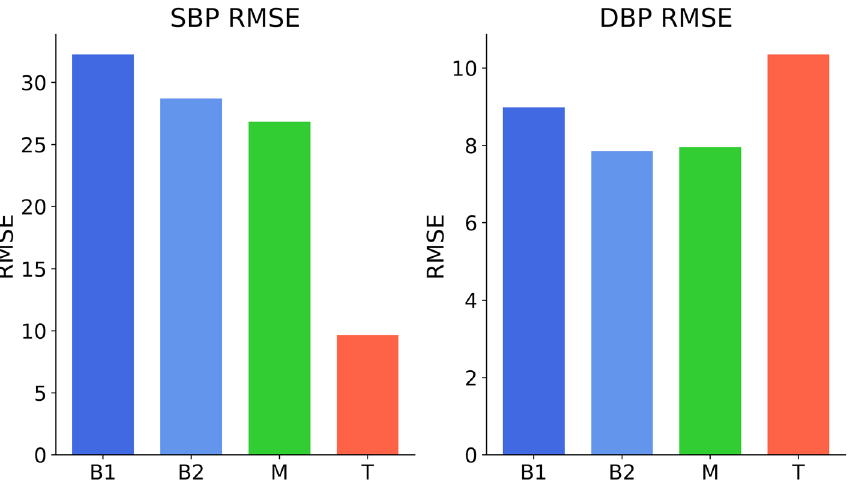
Figure 5. RMSE values calculated for the “dobutamine” dataset. The resulting systolic B-Score was 0.943. The diastolic B-Score is < 0.00 as the T-RMSE is not smaller than the M-RMSE. Diverging systolic and diastolic relative performances are apparent. The systolic RMSE values were B1 = 32.25, B2 = 28.71, M = 26.83, T = 9.64. The diastolic RMSE values were B1 = 8.98, B2 = 7.86, M = 7.95, T = 10.35.